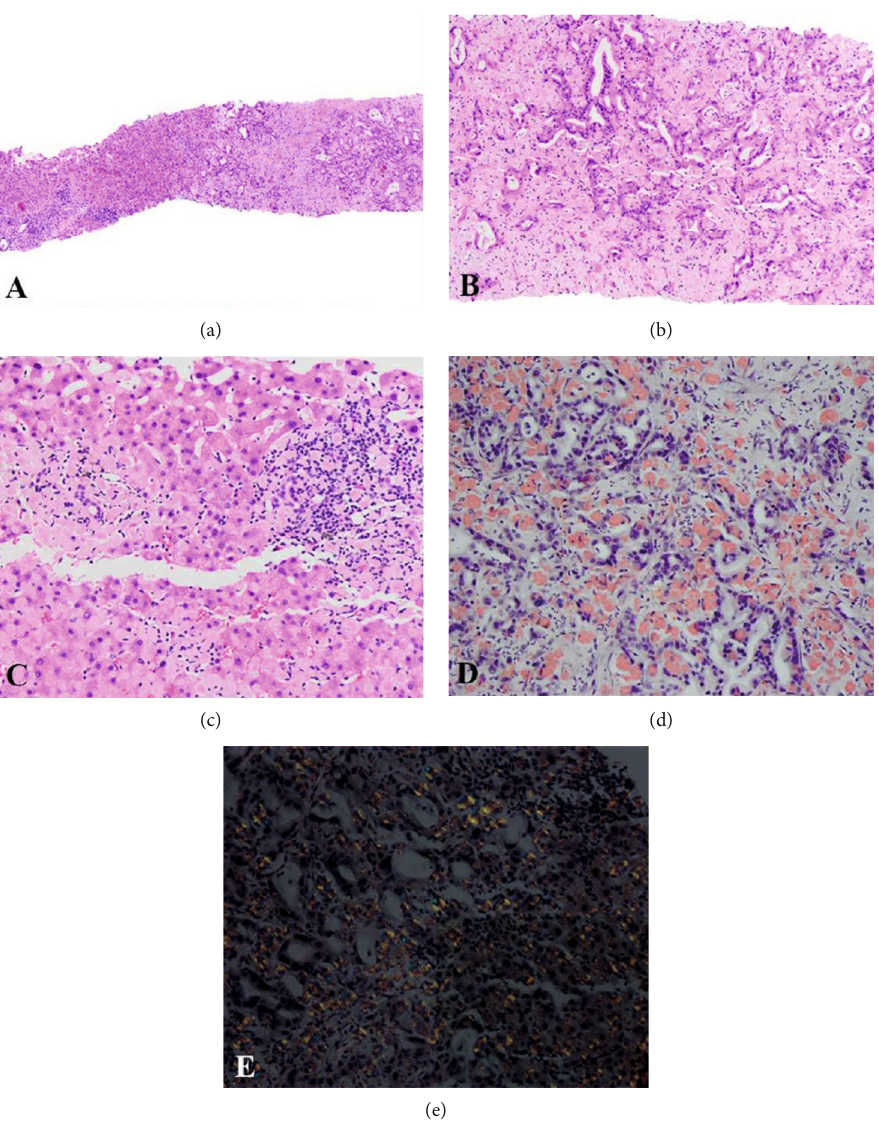
Figure 1: Liver biopsy (a, b) in fi ltration of normal hepatic parenchyma by irregular glands with surrounding eosinophilic material (H&E; (a) 40x, (b) 100x); (c) eosinophilic material with a globular morphology (H&E, 200x); (d) eosinophilic material appearing salmon-orange on Congo red stain (Congo red, 100x); (e) eosinophilic material with apple-green birefringence under polarized light (Congo red, polarized,